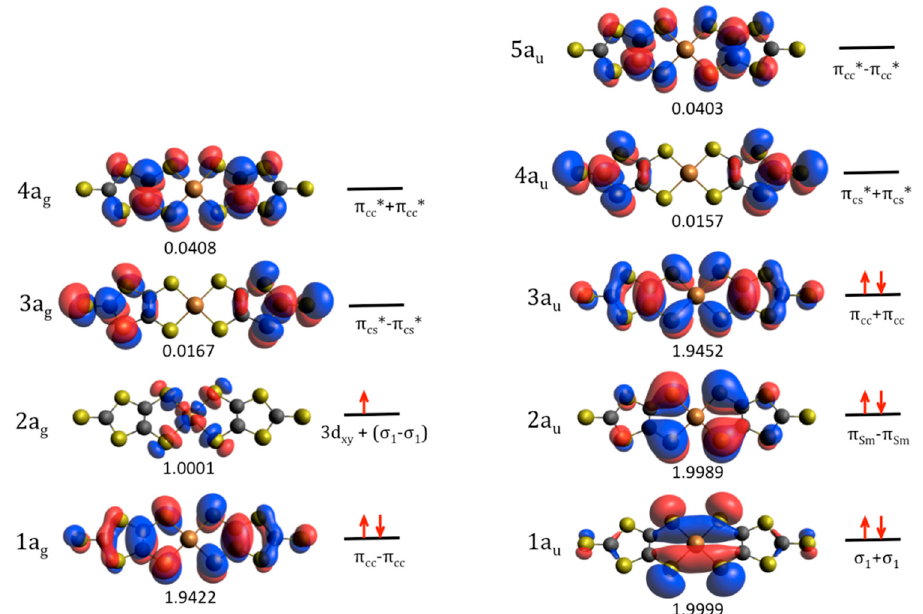
Figure 4. Active orbitals employed in the CASSCF/CASPT2 calculations of the ground and excited doublet states of the [Cu(dmit) 2 ] − 2 complex and occupation number of the natural active orbitals for the ground state. The red arrows represent the occupation of the active MOs on the dominant electronic configuration (84% of the weight) of the 2 Ag ground state.